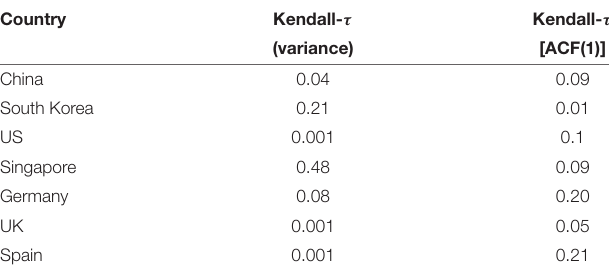
TABLE 1 | Probability of, by chance, obtaining the observed trend statistic of the original data for the set of 1,000 surrogates having similar distribution (mean and variance) as the original datasets.